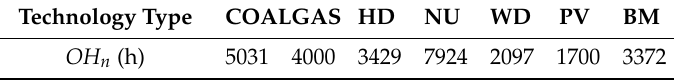
Table 8. Annual operating time of the power technologies of all